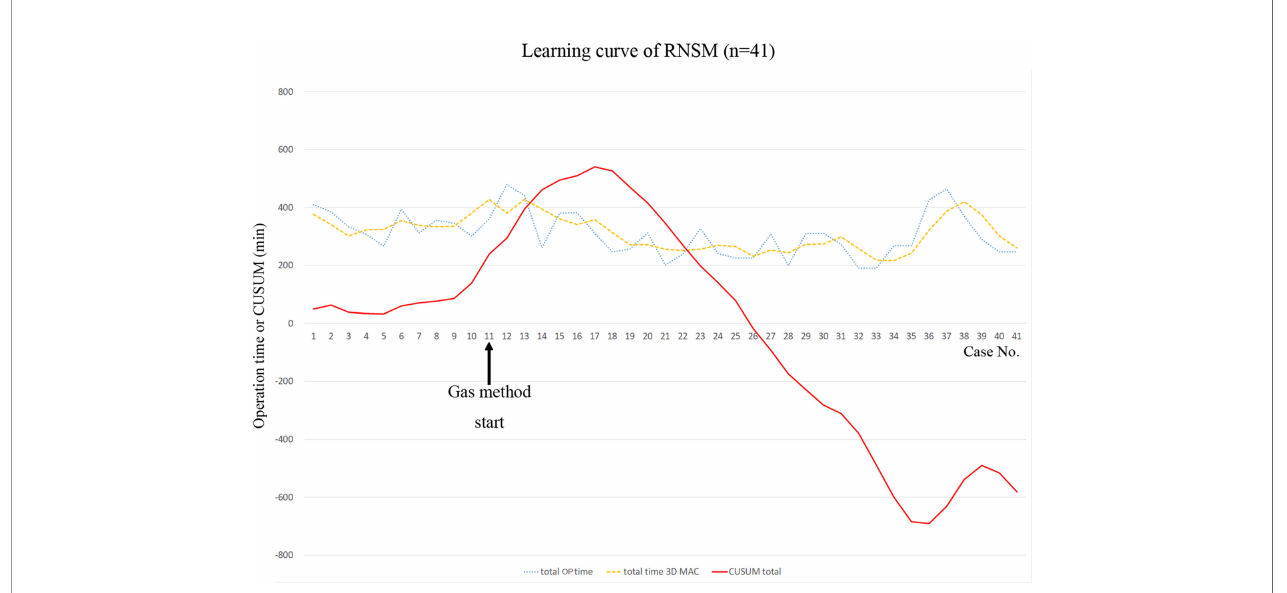
FIGURE 4 | Learning curve of robot-assisted nipple-sparing mastectomy. CUSUM , cumulative sum technique; OP , operation; RNSM , robot-assisted nipple-sparing mastectomy; 3D MAC , 3-day moving average